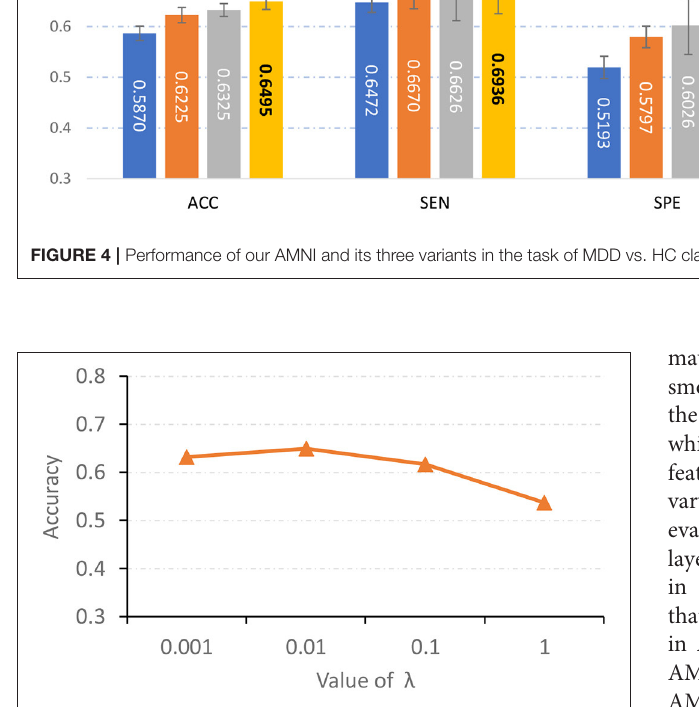
FIGURE 5 | Accuracy achieved by the proposed AMNI method with different values of λ in Equation (11) in the task of MDD vs. HC classification.